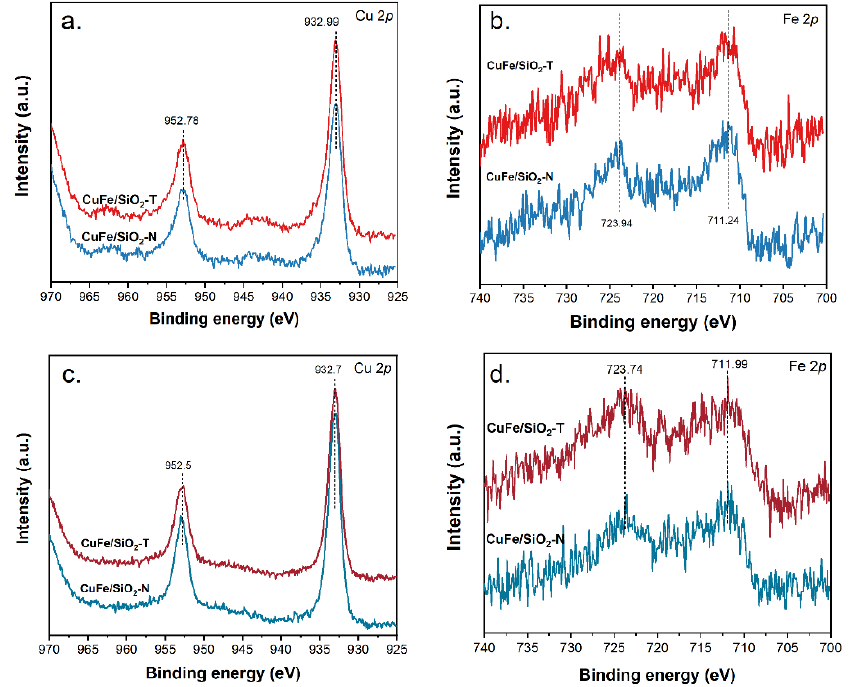
Figure 3. XPS spectra of the fresh and reduced catalysts: ( a ) Cu 2p spectra of fresh samples; ( b ) Fe 2p spectra of fresh samples; ( c ) Cu 2p spectra of used samples; and ( d ) Fe 2p spectra of used samples. Table 2. XPS results of CuFe/SiO 2 -N and CuFe/SiO 2 -T catalysts. Relative surface concentration of catalysts (at. %) Catalyst